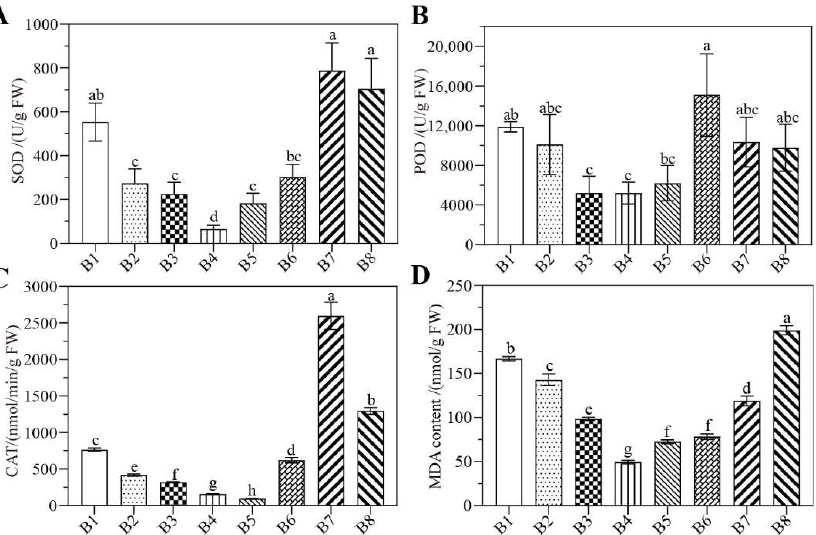
Figure 3. Antioxidase activities and MDA content of flue-tobacco seedlings under different B con- centrations. Note: antioxidant enzymes activities and MDA content in flue-cured tobacco seedlings under different B concentrations. ( A ) SOD activities. ( B ) POD activities. ( C ) CAT activities. ( D ) MDA content. Different lower letters denote significant differences at p < 0.05 following Duncan’s multiple- range test.